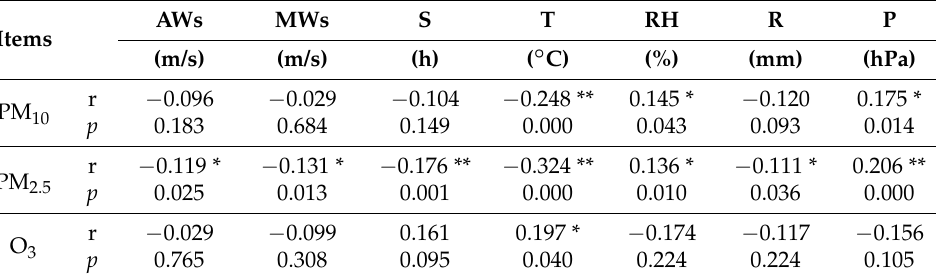
Table 3. Analysis of the relationships between air pollutants and meteorological factors based on Pearson’s correlation coefficients. The correlations are expressed as Pearson’s correlation coefficient, where “*” and “**” denote significant correlations at p < 0.05 and p < 0.01 (two-tailed), respectively. AWs, MWs, S, T, RH, R, and P denote the daily average wind speed, daily maximum wind speed, sunshine duration, daily mean temperature, relative humidity, daily precipitation amount, and surface pressure,